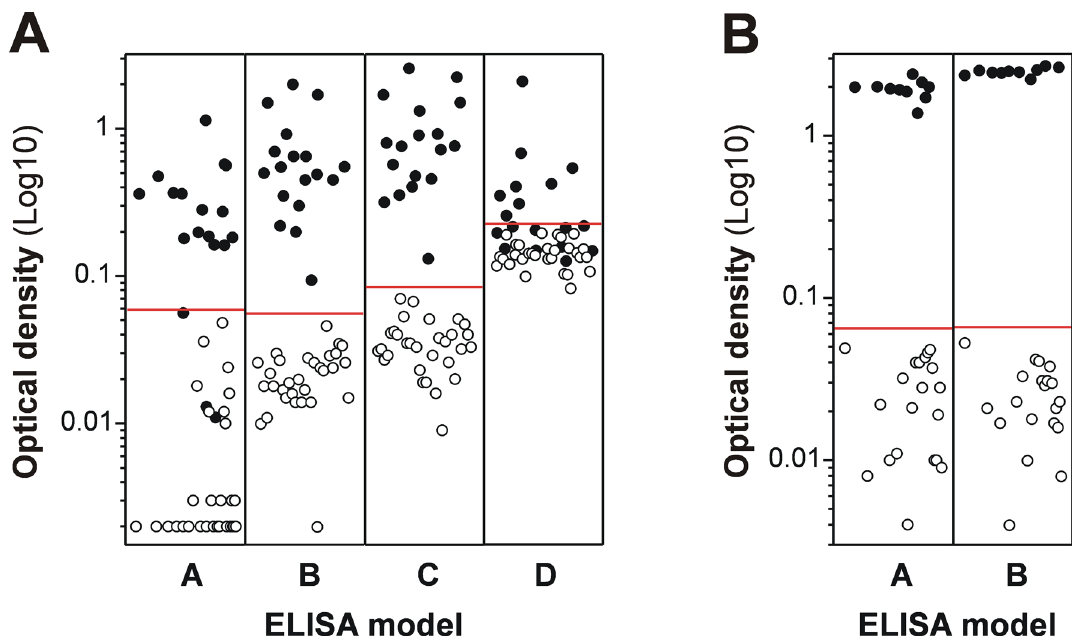
Fig 4. MM3-COPRO OD values obtained for individual Fasciola hepatica positive and negative cattle and sheep feces. (A) F . hepatica positive (n = 18, closed circles) and negative (n = 30, open circles) samples from cows tested with several variations of the MM3-COPRO test (models A-D). (B) F . hepatica positive (n = 10, closed circles) and negative (n = 20, open circles) samples from sheep tested with models B and C. Model A: classic MM3-COPRO test, performed with standard incubations and a former batch of HRP-labeled anti-mouse IgG antibodies. Model B: performed with short incubations (30 min at RT with shaking), using SA-PolyHRP and OPD. Model C: same as model B, using TMB as substrate. Model D: performed with short incubations and a current batch of HRP-labeled anti-mouse IgG antibodies. The red lines correspond to the cut-off value of each ELISA model: 0.059 for model A (cattle); 0.055 (cattle) and 0.064 (sheep) for model B; 0.084 (cattle) and 0.065 (sheep) for model C; and 0.224 (cattle) for model D.